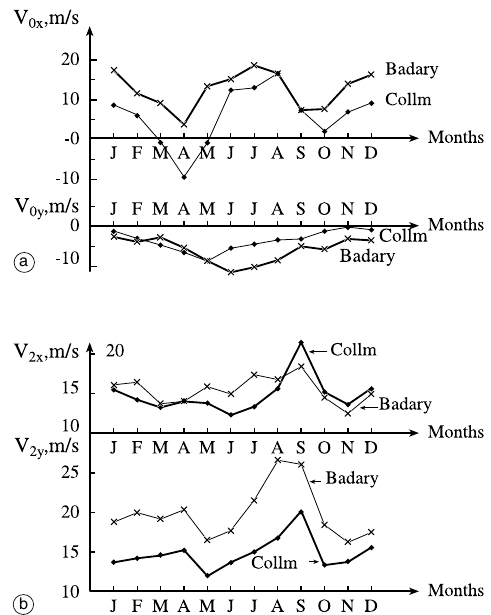
Fig. 7a,b. The non-zonality in the wind field in the lower ionosphere (Kazimirovsky et al., 1999) . Observatory Badary, East Siberia, 52 ° N, 1975-1995. Observatory Collm, Central Europe, 52 ° N, 1979- - prevailing 1997. Data are monthly averaged. V ox zonal wind. V - prevailing meridional wind. Positive oy - amplitude direction - eastward and northward. V 2x of the zonal semidiurnal tide. V - amplitude of the 2y meridional semidiurnal